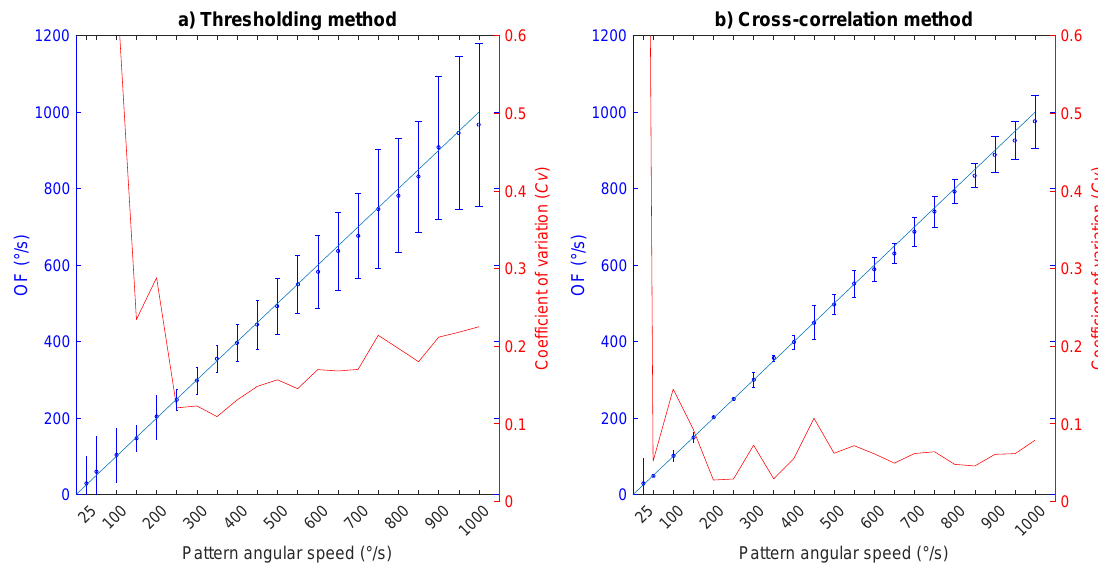
Figure 6. Accuracy of the M 2 APix sensor’s output when using: ( a ) the time-of-travel algorithm based on signal thresholding with F e = 1kHz; and ( b ) the time-of-travel algorithm based on signal cross-correlation with F e = 500Hz. The tests were performed at a constant level of irradiance (7 × 10 − 4 W · cm − 2 ), and the OF produced by the moving pattern was made to vary from 25 °/s to 1000 °/s with steps of 50 °/s (except for the first step). Each graph shows the average µ (blue circles), the standard deviation σ (blue vertical bars) and the coefficient of variation σ measurements with respect to the angular speed of the moving pattern (see Figure 4). The ground-truth values of the OF are given by the blue